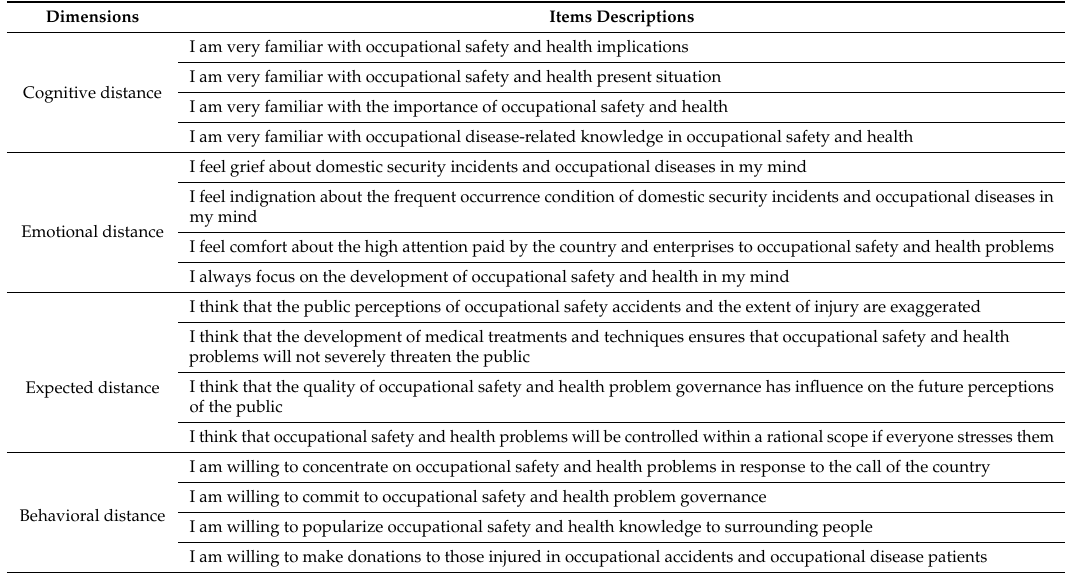
Table A1. The scale items for public occupational safety and health psychological